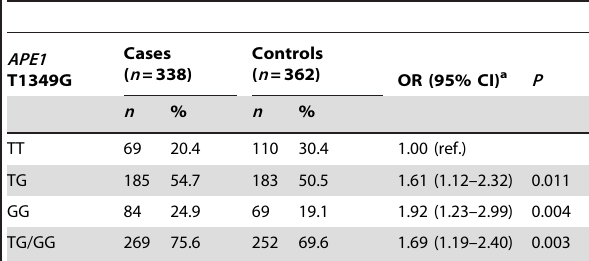
Table 2. Genotype and allele frequencies of the APE1 T1349G polymorphism among the cases and controls and the associations with risk of gastric